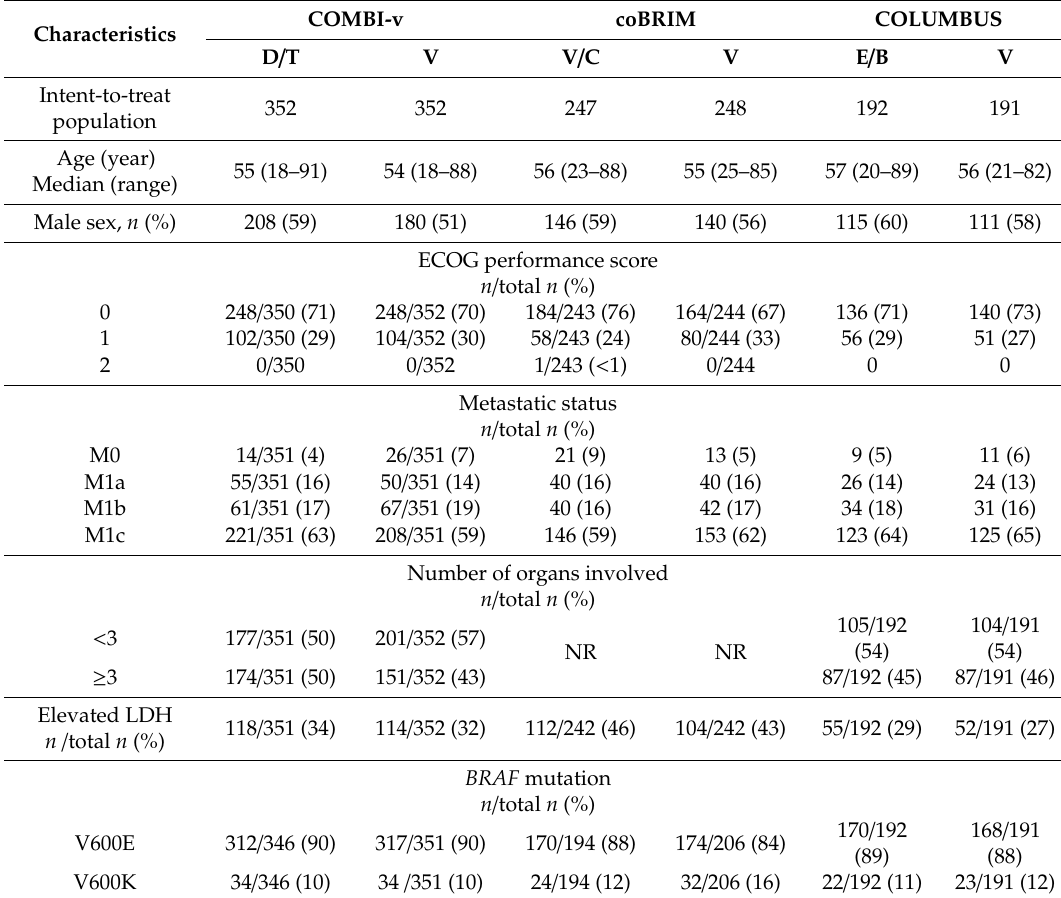
Table 1. Baseline characteristics in the COMBI-v, coBRIM, and COLUMBUS trials [9,10,23]. Characteristics